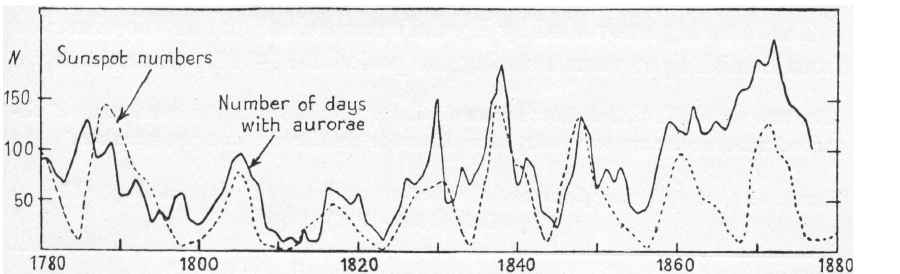
Figure 10. Comparison of sunspot number (Wolf, 1860) with number of days (nights) with observed auroras. Reproduced from data in Tromholt (1898) (Tromholt, 1898; here from Størmer,